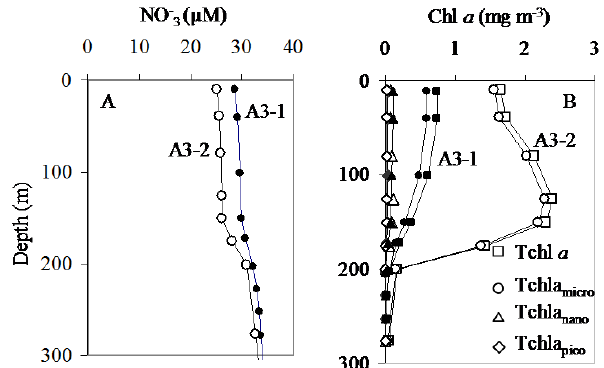
Figure 3. Vertical distribution of the concentration of NO 3 (A) ; total Chl a ( T chl a ) , and T chl a associated with micro-( T chl a ) , and picophytoplankton ( T chl a ( T chl a nano bols indicate pre-bloom stage; the hollow symbols indicate early bloom